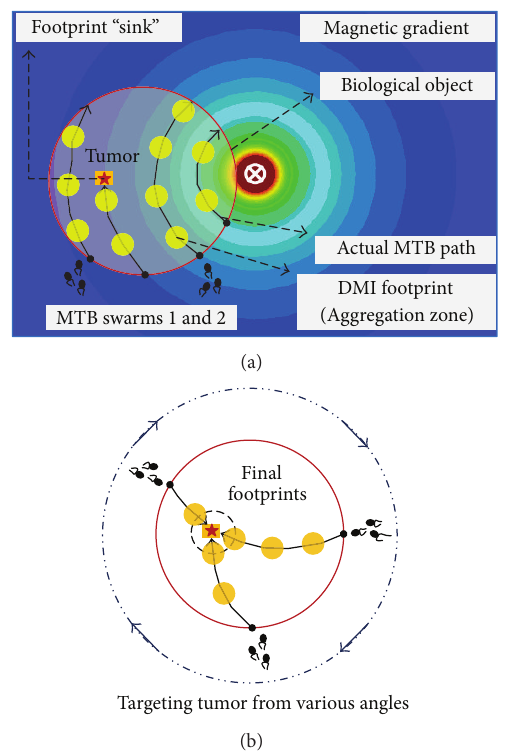
Figure 2: Illustration of (a) cancer detection and (b) examination with multiswarm MTB